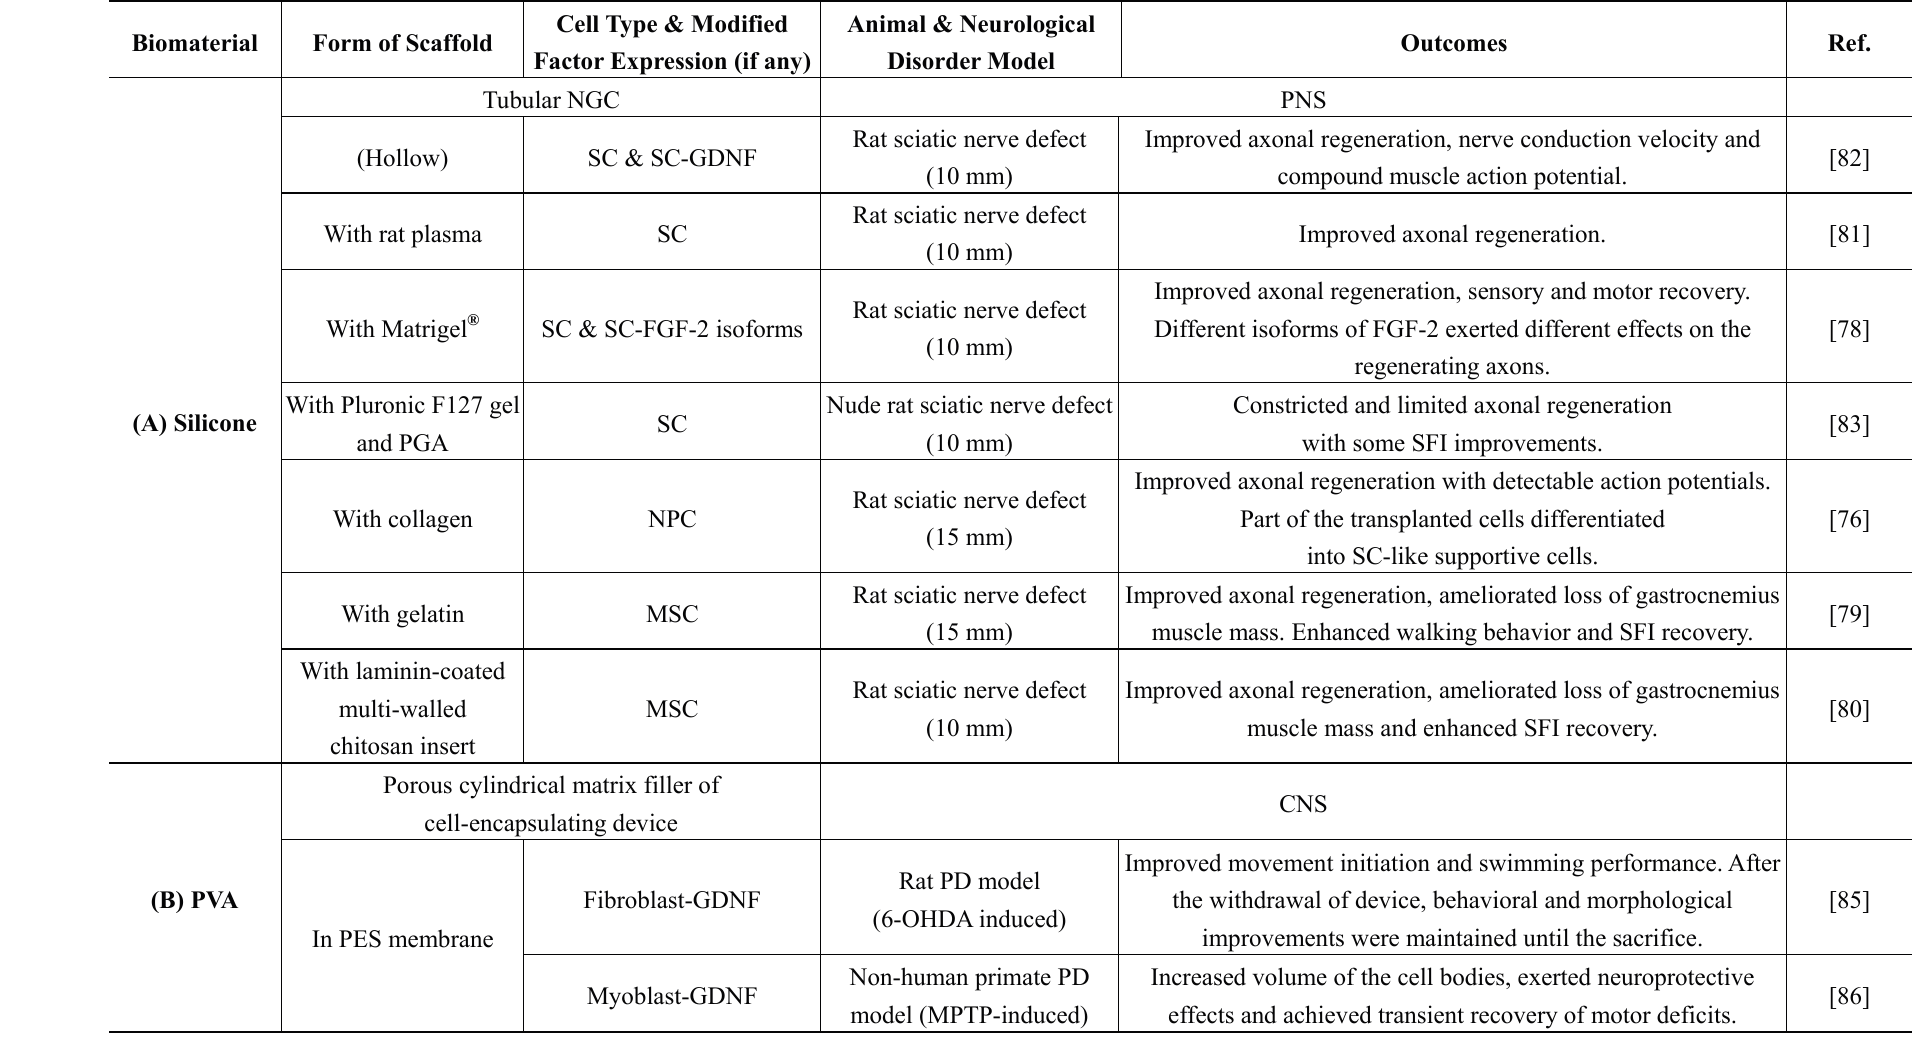
Table 1. Examples of non-biodegradable cell-carriers applied in preclinical animal studies and clinical trials.